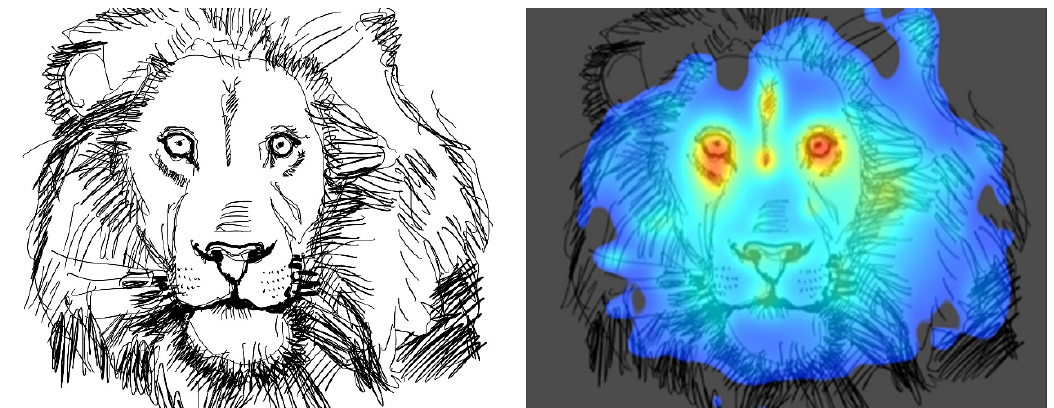
Figure 17. A Lion’s head sketch and the heatmap after 3M-VAS scanning.